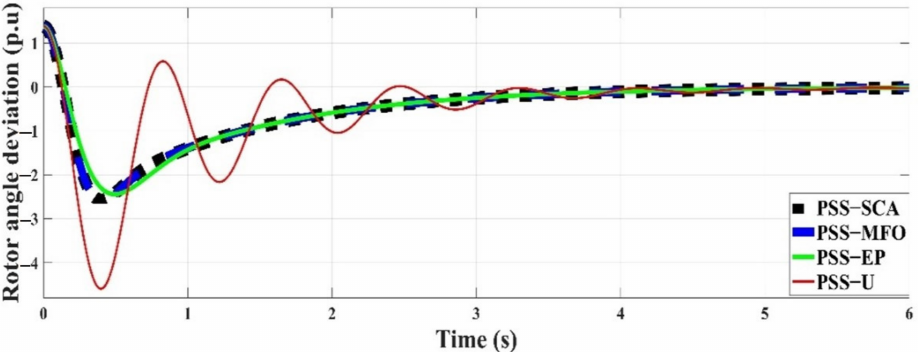
Figure 7. Rotor angle deviation for loading condition 1 of the SMIB with